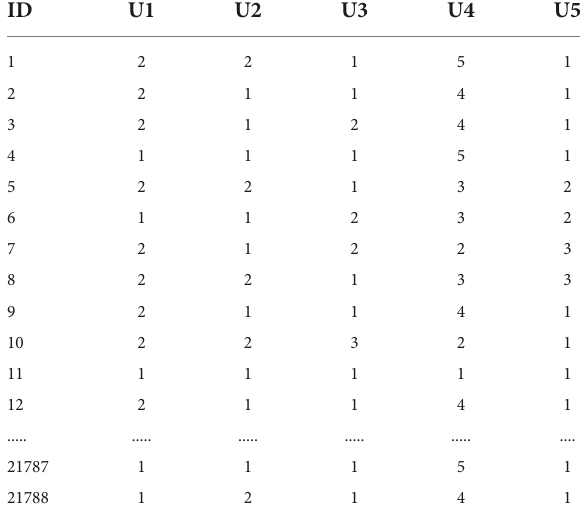
TABLE 3 Latent class analysis input